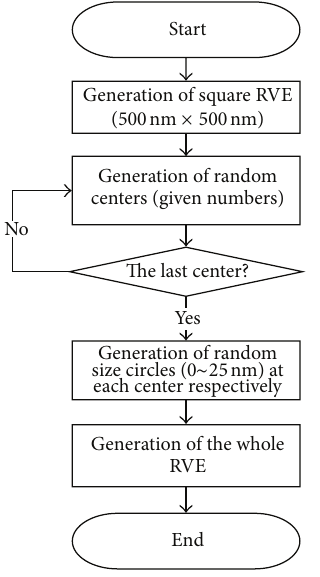
Figure 5: Programming process for generation of RVE.